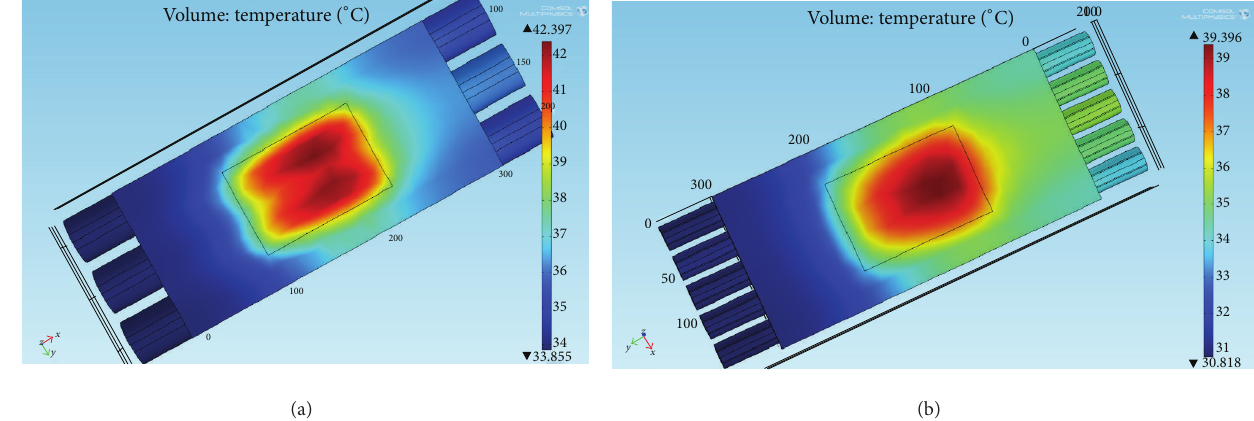
Figure 4: Computer simulations results for (a) 1 󸀠󸀠 pipes and (b) 3/4 󸀠󸀠 pipes.